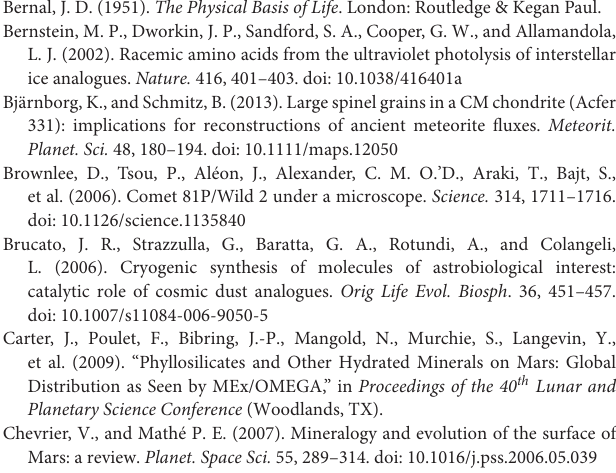
Supplementary Figure A1 | Infrared spectrum of pure milled and dried GLY in range 8,000–400 cm − 1 . Supplementary Figure A2 | Infrared spectrum of for sterite (grain dimension 20–50 µ m), either pure or GLY-spiked, in the range 4,000–400 cm − 1 . Supplementary Figure A3 | Infrared spectrum of antigorite (grain dimension 20–50 µ m), either pure or GLY-spiked, in the range 4,000–400 cm − 1 . Supplementary Figure A4 | Infrared spectrum of spinel (grain dimension 20–50 µ m), either pure or GLY-spiked, in the range 4,000–400 cm − 1 . Supplementary Figure A5 | Infrared spectrum of pyrite (grain dimension 20–50 µ m), either pure or GLY-spiked, in the range 4,000–400 cm − 1